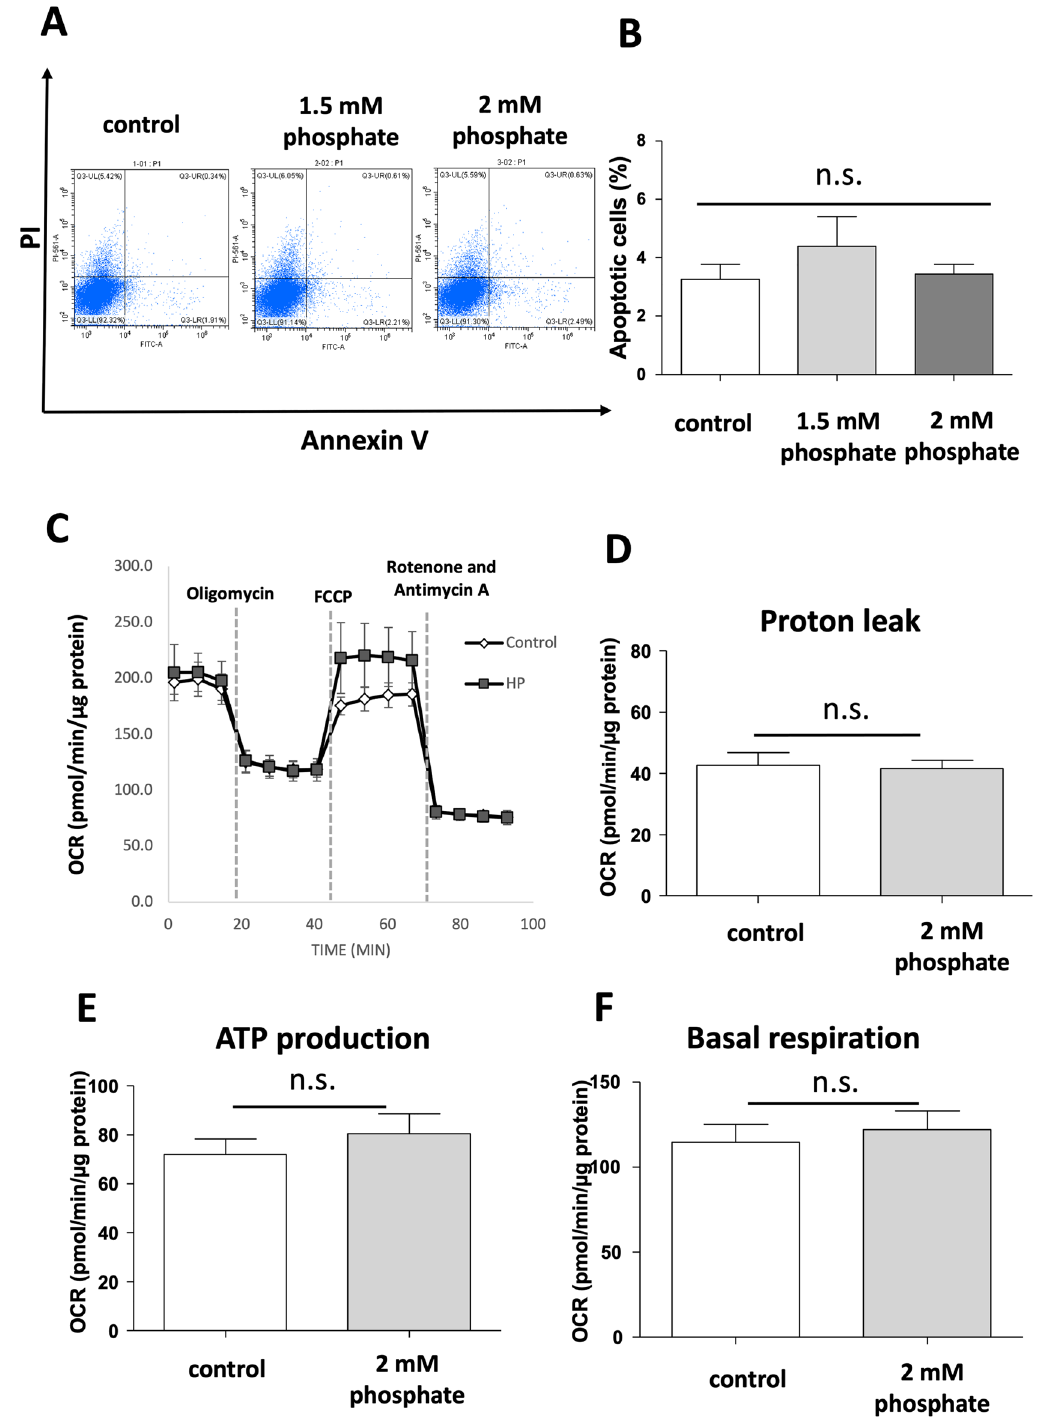
Figure 4. Effects of phosphate on DolKT-1 cell apoptosis and mitochondrial function. Apoptotic cells were determined using flowcytometry with annexin V/PI double staining ( A ). Data were analyzed by CytExpert ver. 2.3 (https:// www. beckm an. com/ flow- cytom etry/ resea rch- flow- cytom eters/ cytofl ex/ softw are). The bar graph shows the percentage of apoptotic cells in each experimental group, n = 4 for each group ( B ). DolKT-1 cells were pretreated with 2 mM phosphate for 36 h and mitochondrial function was measured by flux analysis. Oxygen consumption rate ( C ), proton leak ( D ), ATP production ( E ), and basal respiration ( F ). n = 2 for each group. n.s not significant, PI propidium